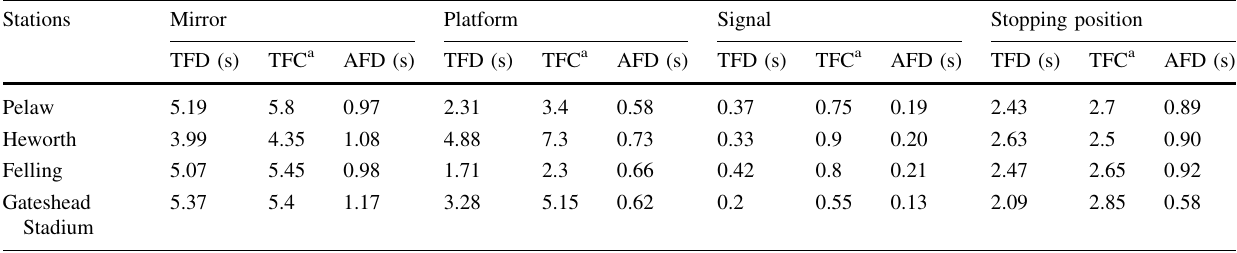
Table 3 Descriptive statistics for station arrivals (data related to mean values of 20 samples) Stations Mirror Platform Signal Stopping position